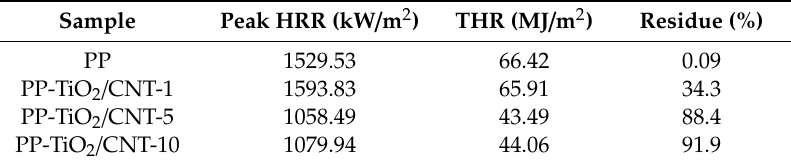
Table 7. Data of the calorimetric cone test of the samples analyzed.